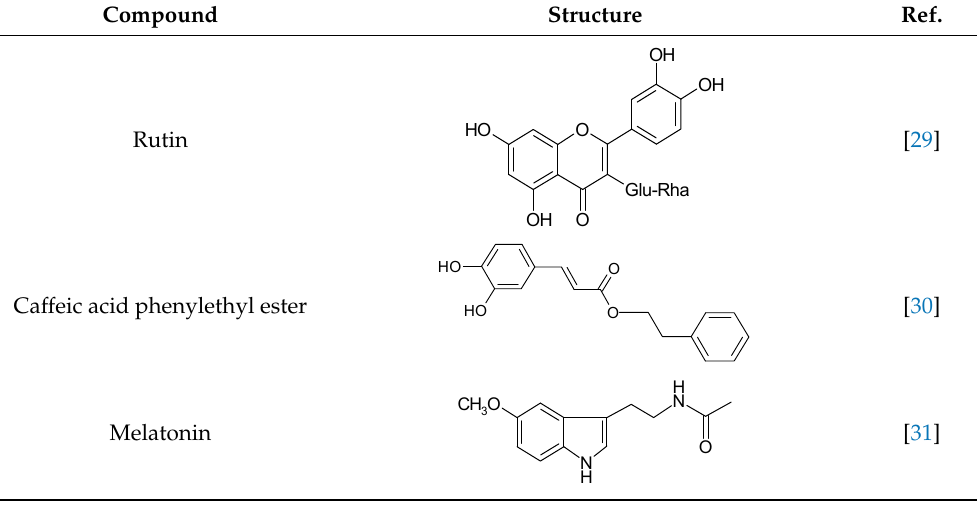
Table 2. Cont. Compound Structure Ref.